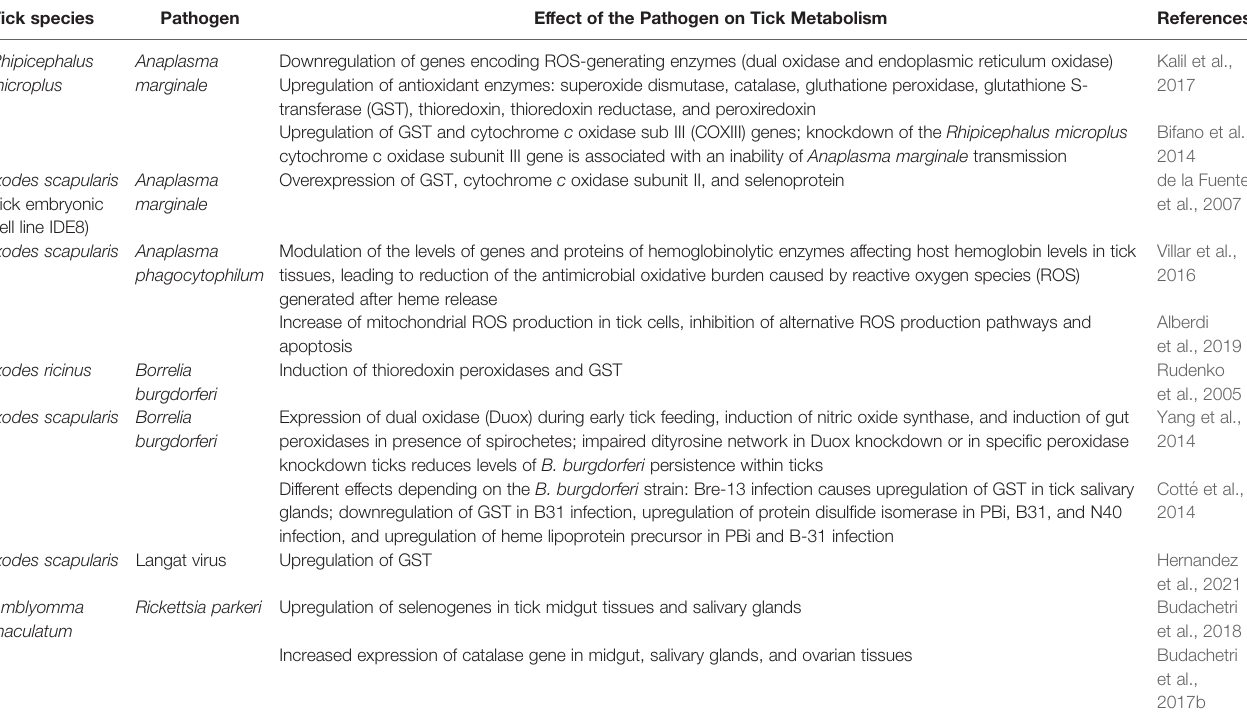
TABLE 1 | Tick redox metabolism changes associated with tick-borne pathogen